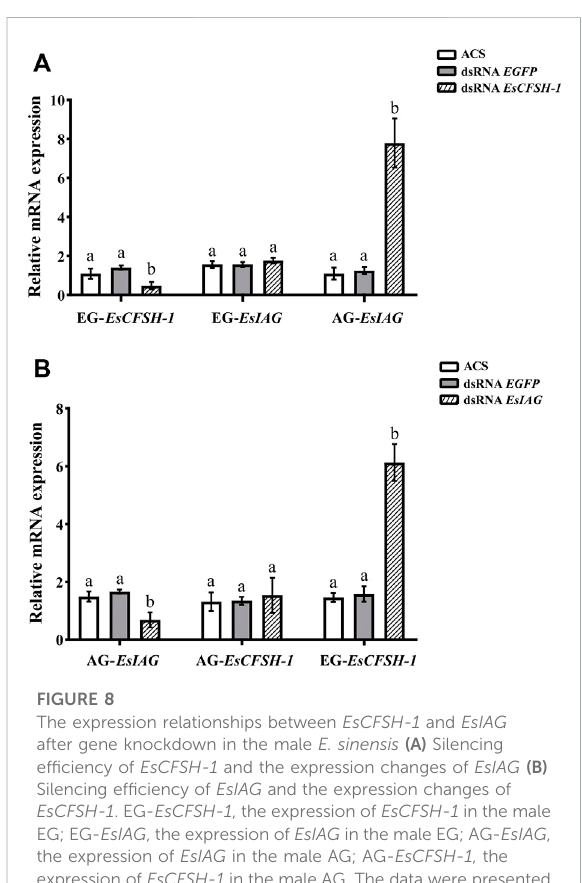
FIGURE 8 The expression relationships between EsCFSH-1 and EsIAG after gene knockdown in the male E. sinensis (A) Silencing ef fi ciency of EsCFSH-1 and the expression changes of EsIAG (B) Silencing ef fi ciency of EsIAG and the expression changes of EsCFSH-1 . EG- EsCFSH-1 , the expression of EsCFSH-1 in the male EG; EG- EsIAG , the expression of EsIAG in the male EG; AG- EsIAG , the expression of EsIAG in the male AG; AG- EsCFSH-1 , the expression of EsCFSH-1 in the male AG. The data were presented as means ± SEM of four separate individuals ( n = 4). Statistical signi fi cance was accepted at p < 0.05 and shown in different lower-case